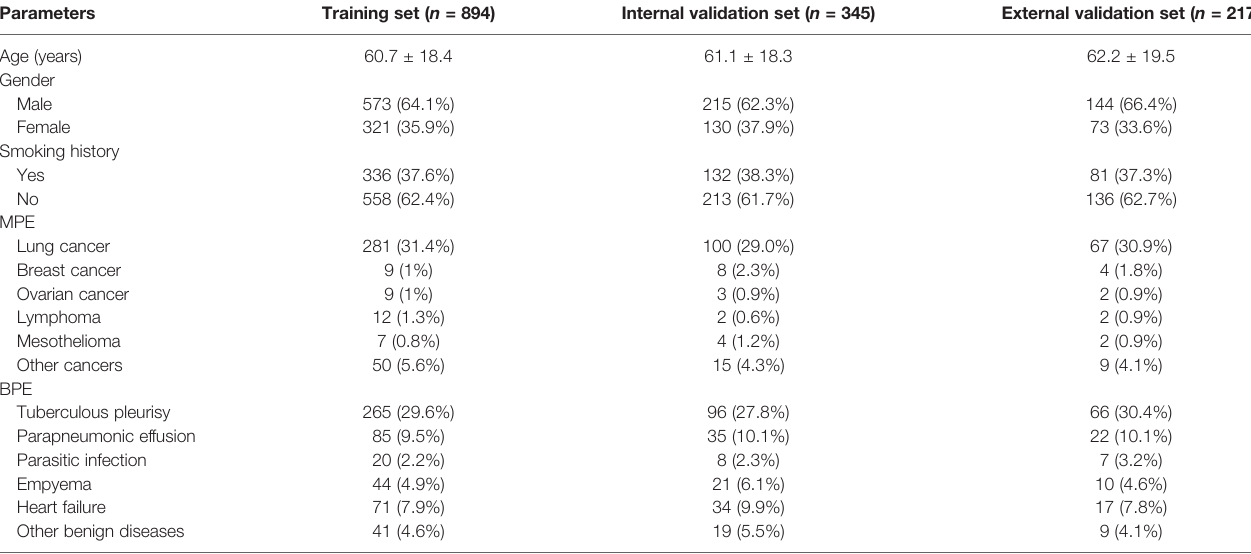
TABLE 1 | Baseline characteristics of the study